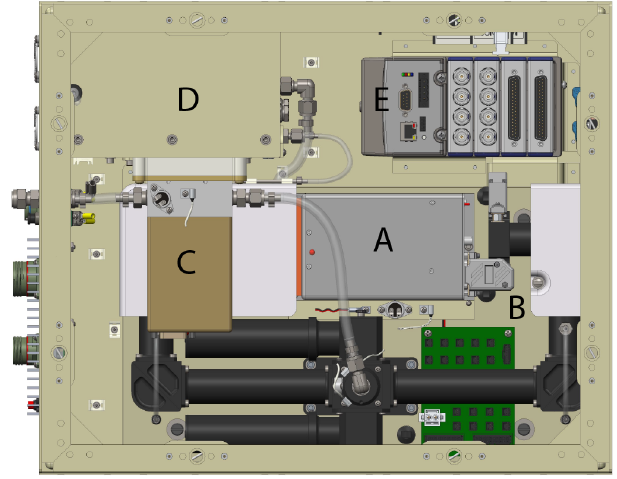
Figure 1. A top view of the CAFE instrument, with major compo- nents labeled: (A) laser, (B) optical plate, (C) pressure controller, (D) pump, and (E) RIO data acquisition